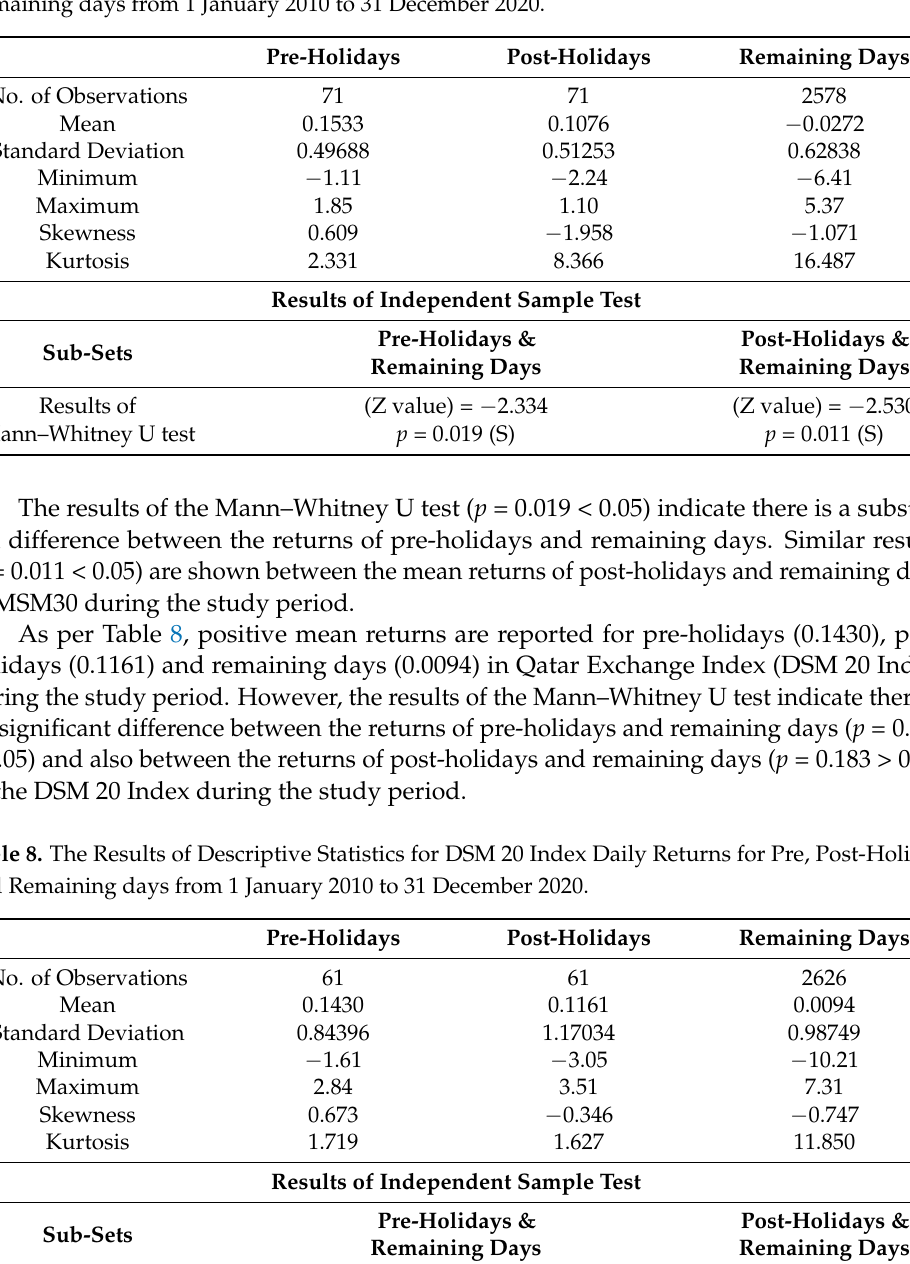
Table 7. The Results of Descriptive Statistics for MSM30 Daily Returns for Pre, Post-Holiday and